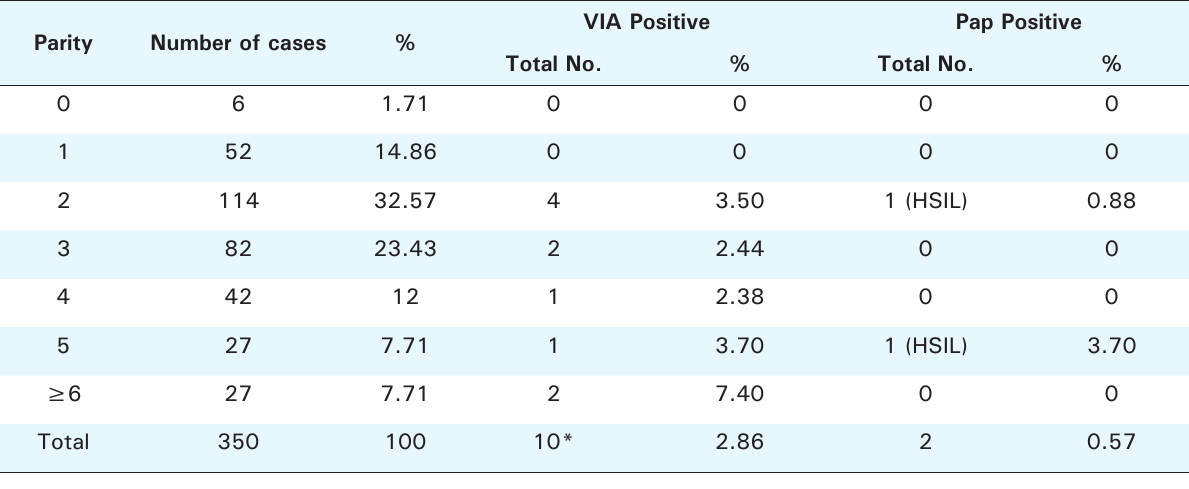
table 2. screening results in relation to Parity